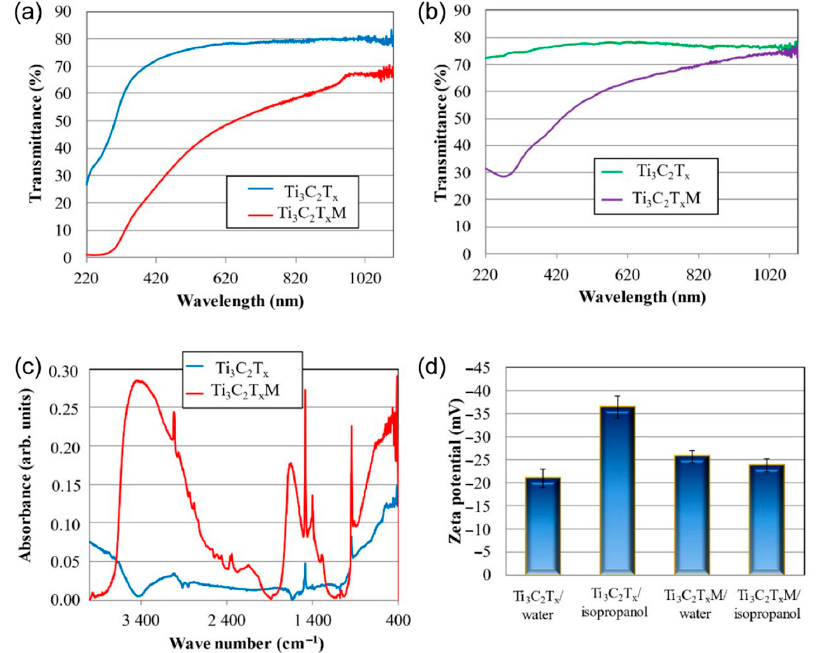
Figure 2. Ultraviolet visible spectrum (UV-VIS) of ( a ) Ti 3 C 2 T x and Ti 3 C 2 T x M in distilled water, ( b ) Ti 3 C 2 T x and Ti 3 C 2 T x M in isopropanol; ( c ) Fourier transform infrared spectroscopy (FTIR) spectrum of Ti 3 C 2 T x and Ti 3 C 2 T x M crystals; ( d ) zeta potential of Ti 3 C 2 T x and Ti 3 C 2 T x M crystals in different